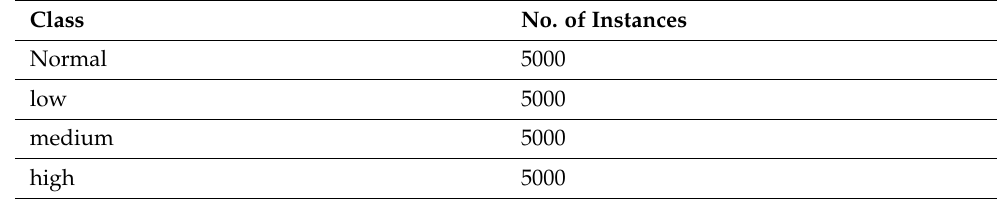
Table 1. Details of dataset.